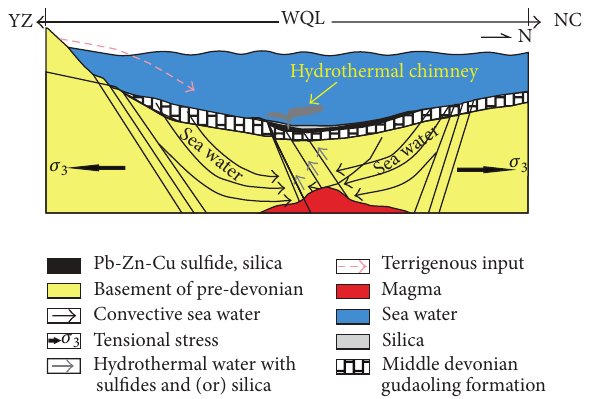
Figure 21: Hydrothermal precipitation model of the Bafangshan- Erlihe area (YZ: Yangtze block, WQL: western Qinling block, NC: North China